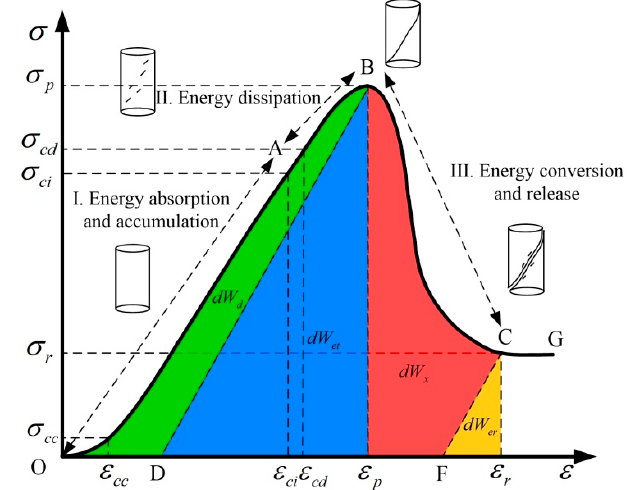
Figure 4. Schematic diagram of energy evolution during the entire process of rock failure.